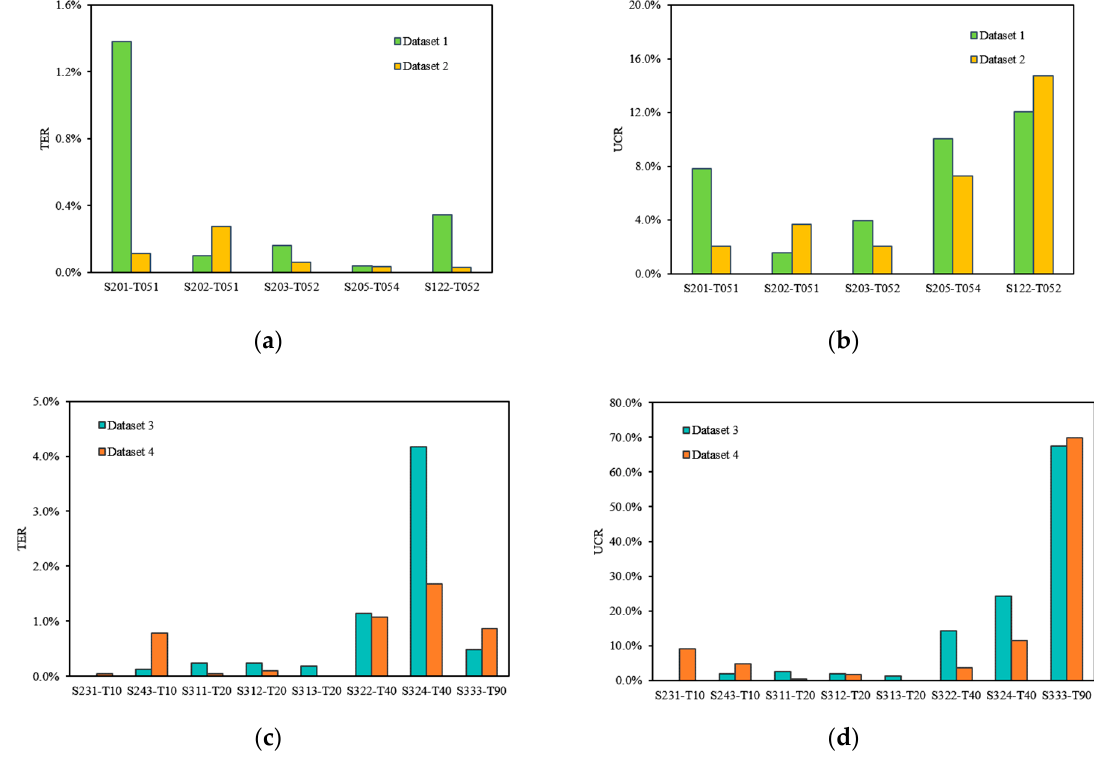
Figure 9. Reliability evaluation of different error types: ( a,b ) total error rate (TER) and uncertainty contribution rate (UCR) of Datasets 1 and 2; ( c,d ) TER and UCR of Datasets 3 and 4.